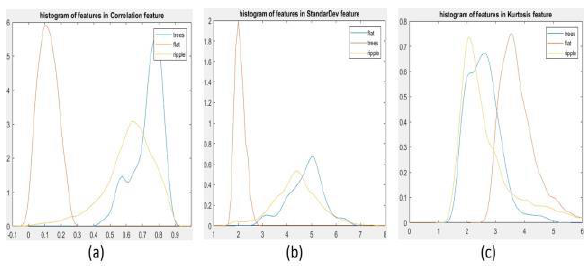
Figure 3: Histograms of Correlation (a), Standard Deviation (b) and Kurtosis (c).